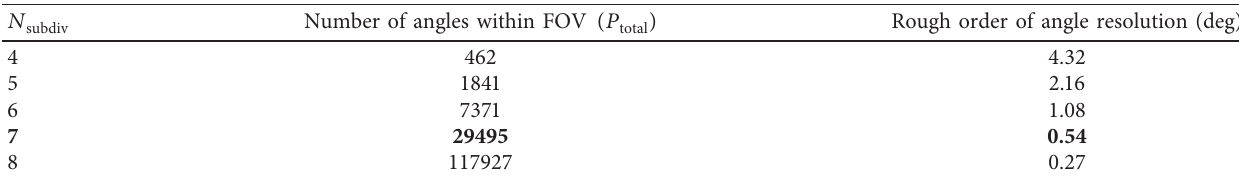
Table 10: Different 2D-angle grids.